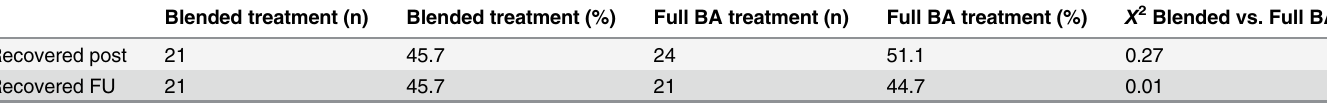
Table 3. Proportion of participants reaching recovery (clinically significant improvement on the BDI-II). Blended treatment (n) Blended treatment